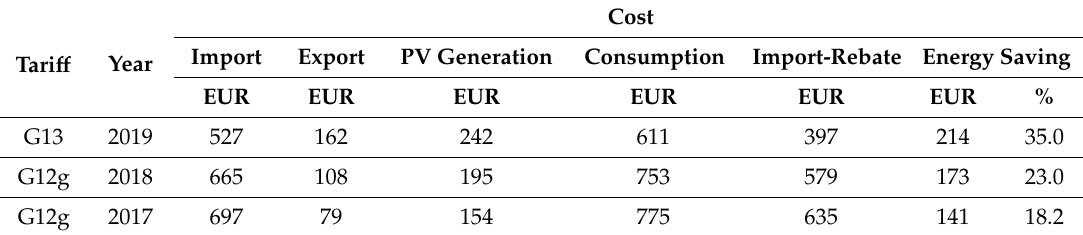
Table 10. Cost of energy exported, imported, and consumed in the building under the G13 and G12g tari ff s.